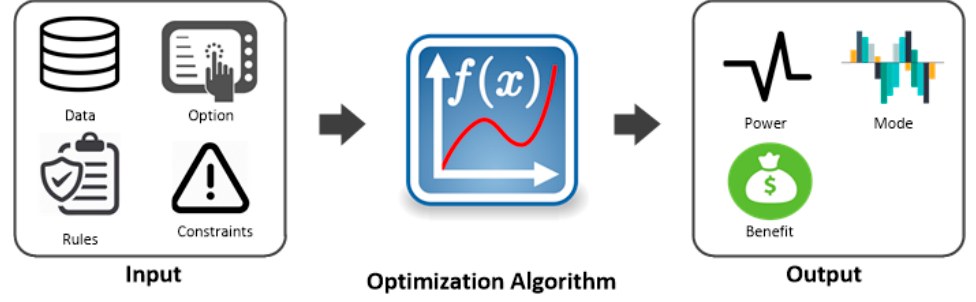
Figure 1. Optimization scheduling algorithm concept.